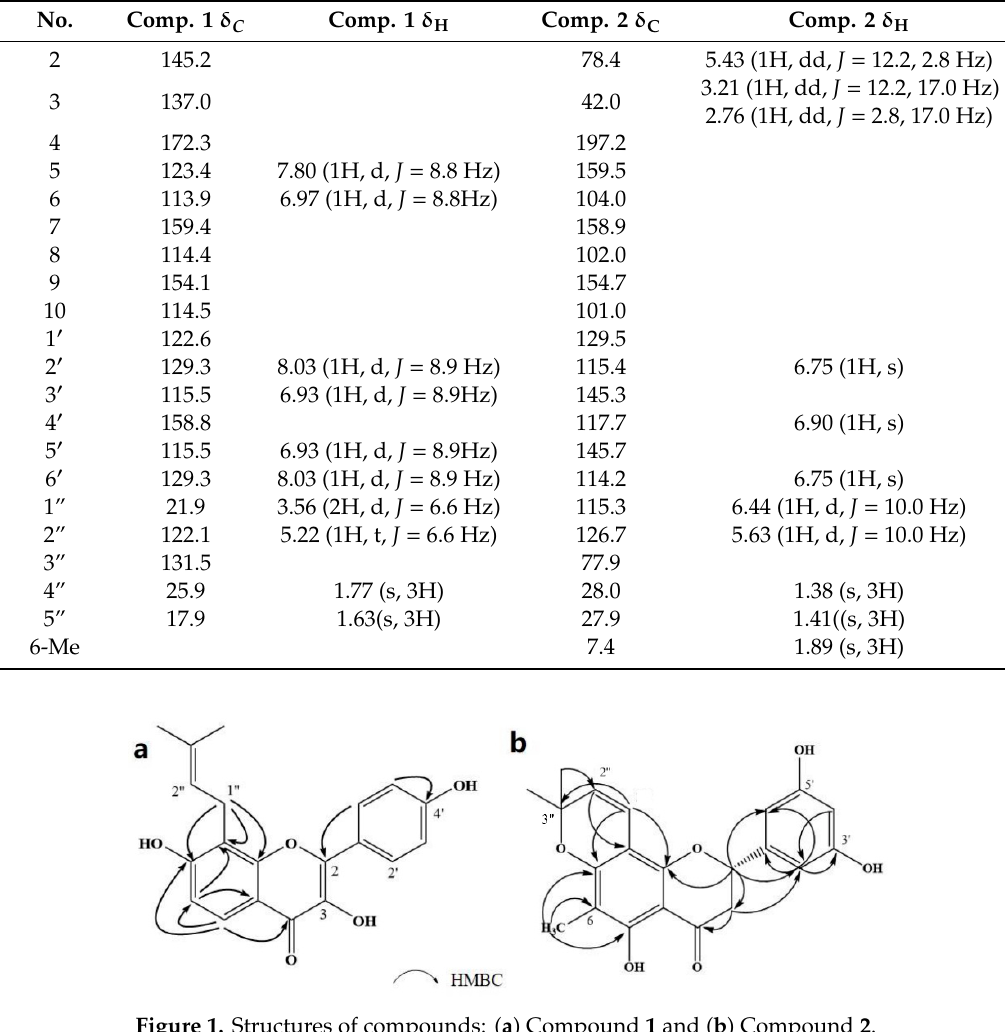
Table 1. Data for Compounds 1 and 2 in DMSO- d 6 (600 MHz for 1 H-NMR, 150 MHz for 13 C-NMR).